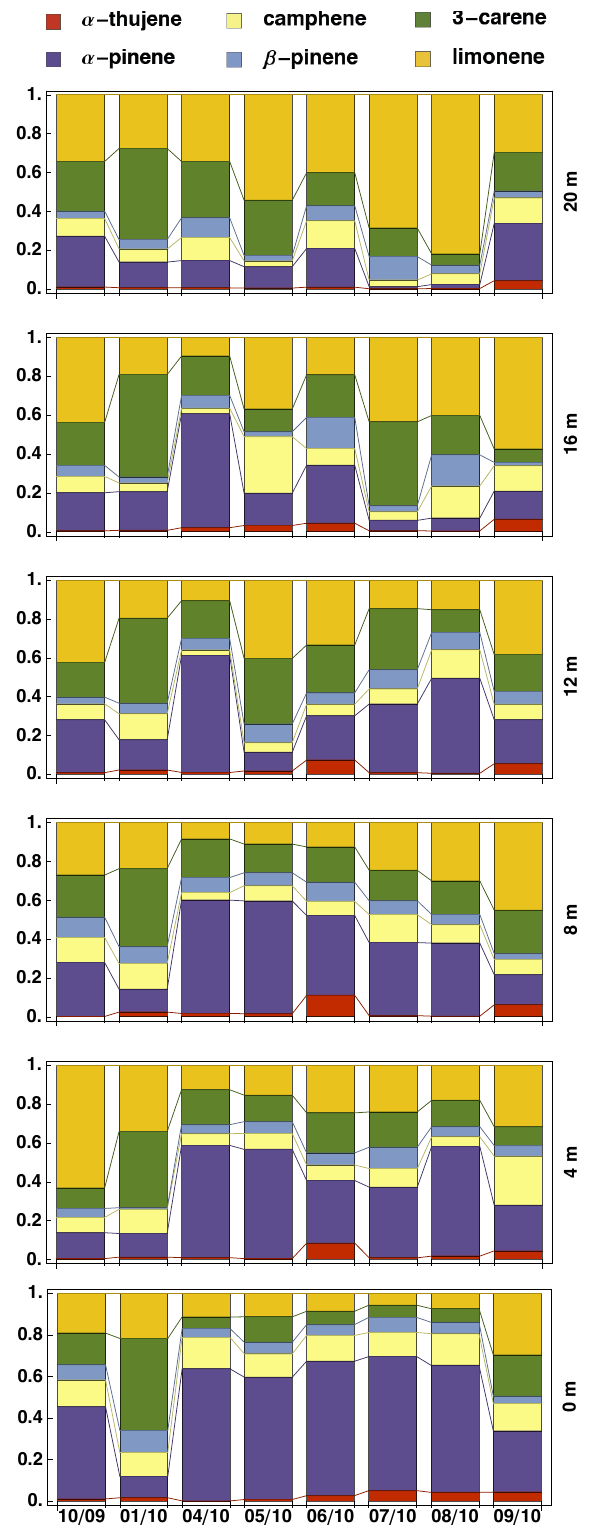
Fig. 5. Spatial and temporal relative contribution per monoterpene species scaled to the total monoterpene